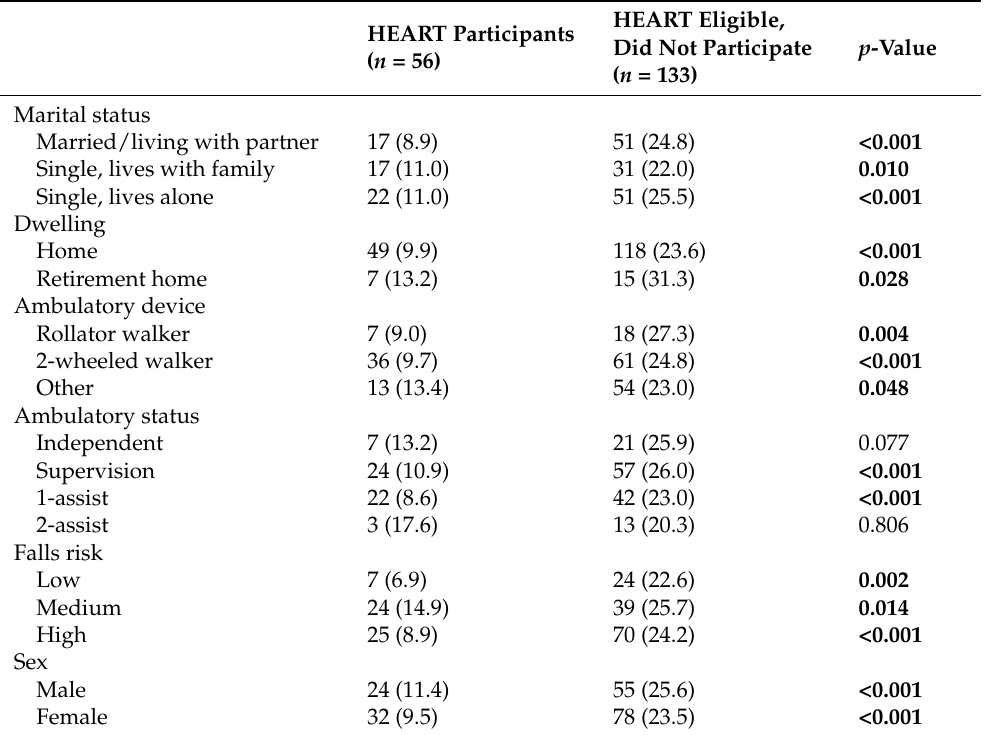
Table 4. HEART and non-HEART participants who did not return home based on predictor vari- ables, n